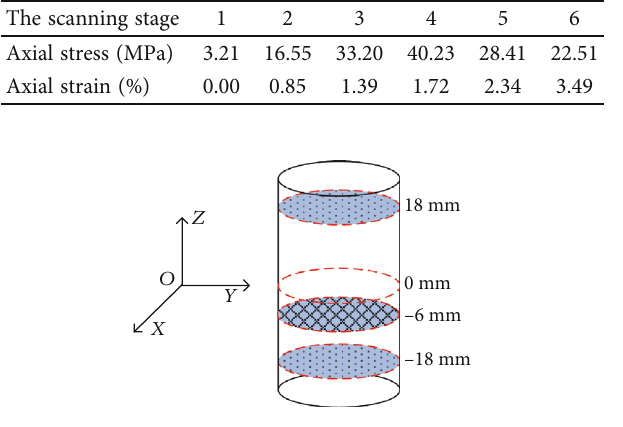
Figure 5: The ROI of the coal sample.